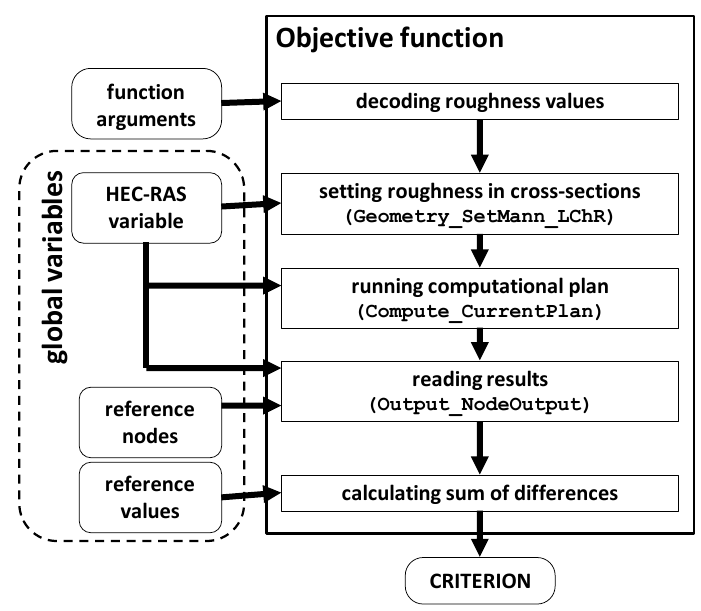
Figure 3. Algorithm for calculation of objective function values.